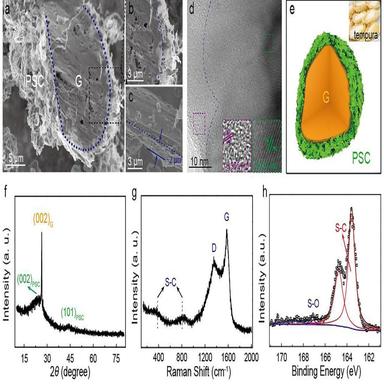
Characterizations of G@PSC: (a–c) SEM images. (d) HRTEM image (plotting scale of the insets: 1 nm). (e) The structural schematic diagram. (f) XRD pattern. (g) Raman spectrum. (h) The deconvoluted XPS spectrum (S 2p).